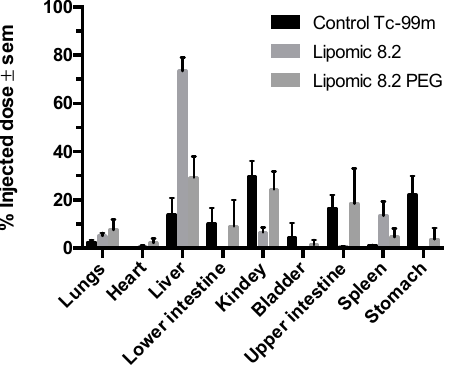
Figure 13. Biodistribution of 99m TcO 4 − , lipomics, and PEG lipomics as the percentage of injected dose (injected activity per organ weight) quantified after the animal sacrifice (n = 3–5), 3 h after injection.